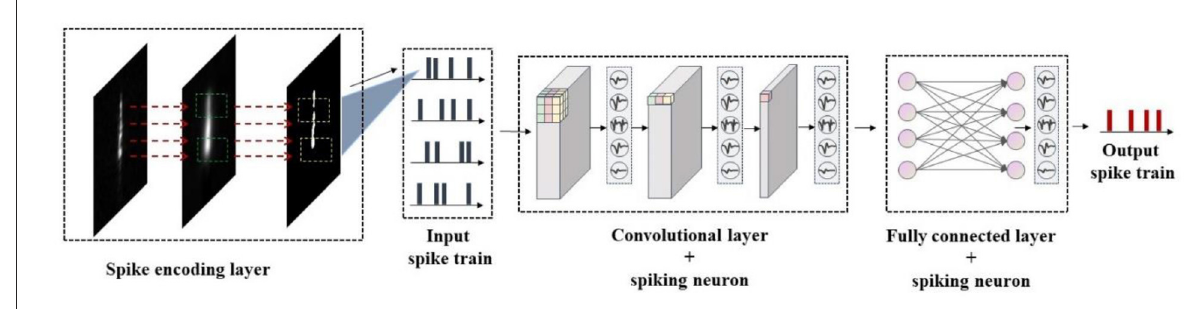
FIGURE1 Model framework of the proposed SpikingSAR algorithm.